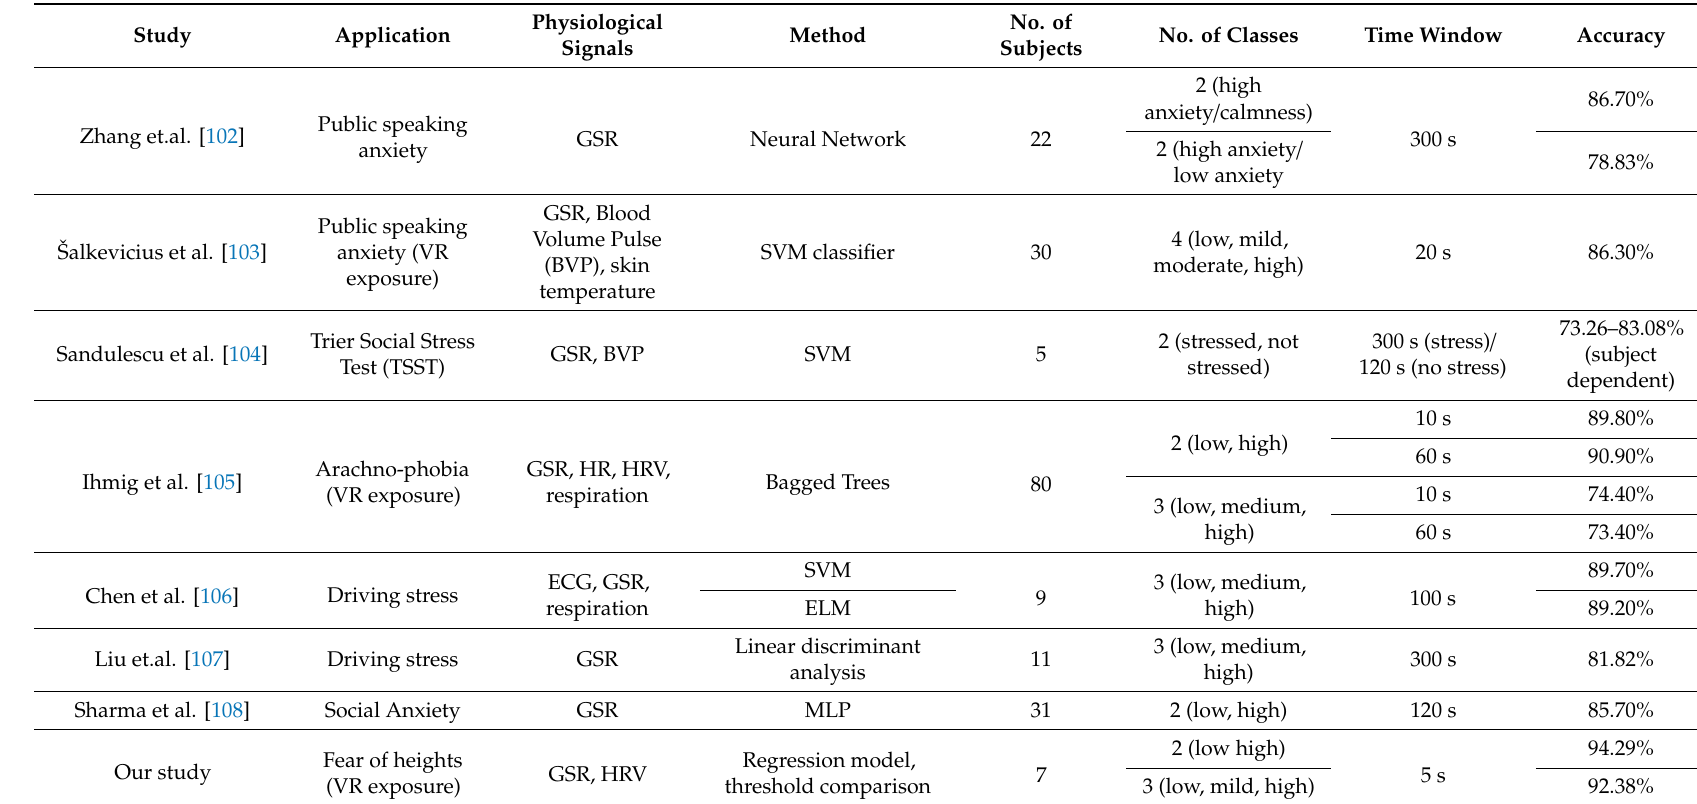
Table 13. Comparison between di ff erent classifiers found in literature and our